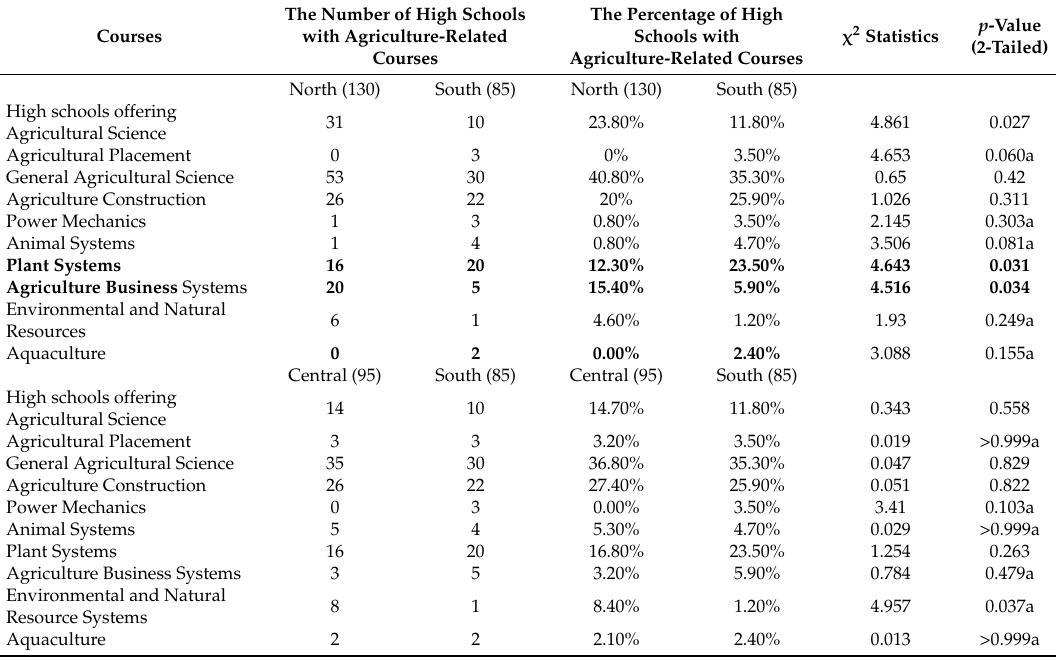
Table 2. The Prevalence of courses related to agricultural fields in high schools across Alabama’s regions.